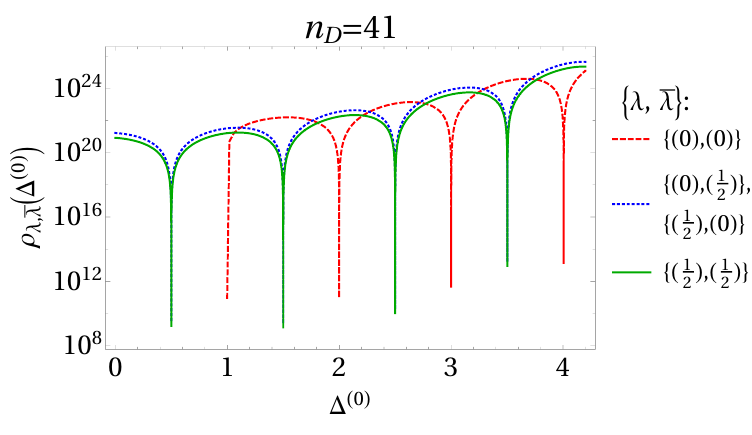
Figure 13 . Extremal functional of SU(2) k = 1, c = 3